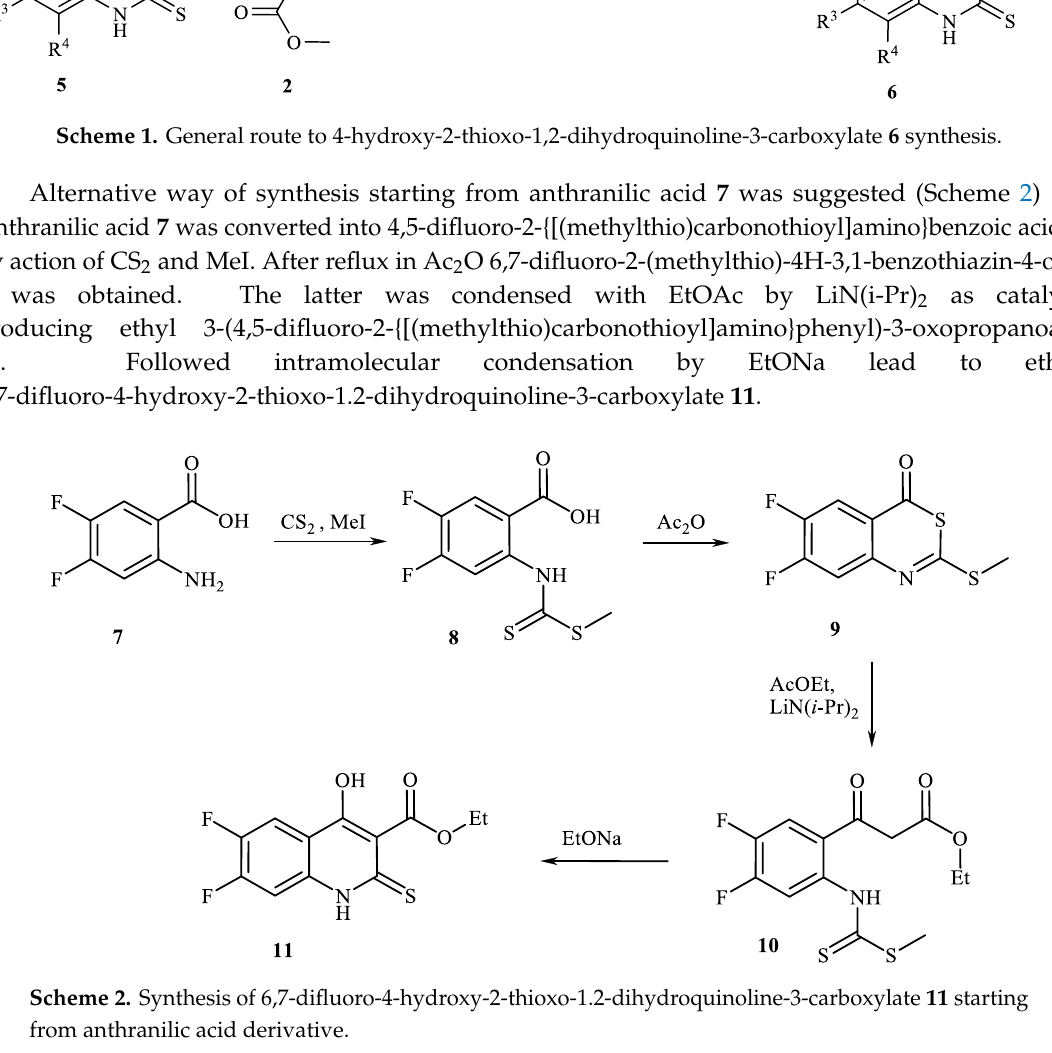
Scheme 2. Synthesis of 6,7-difluoro-4-hydroxy-2-thioxo-1.2-dihydroquinoline-3-carboxylate 11 starting from anthranilic acid derivative.